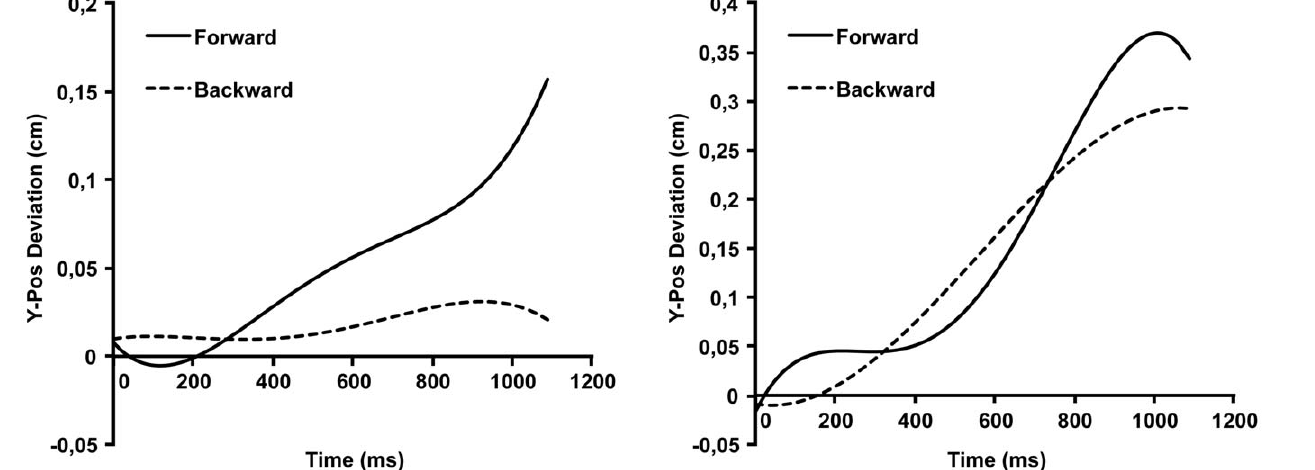
Figure 4. Estimated averaged response curves of y-axis movements from x-axis response onset to response offset in the sitting condition.